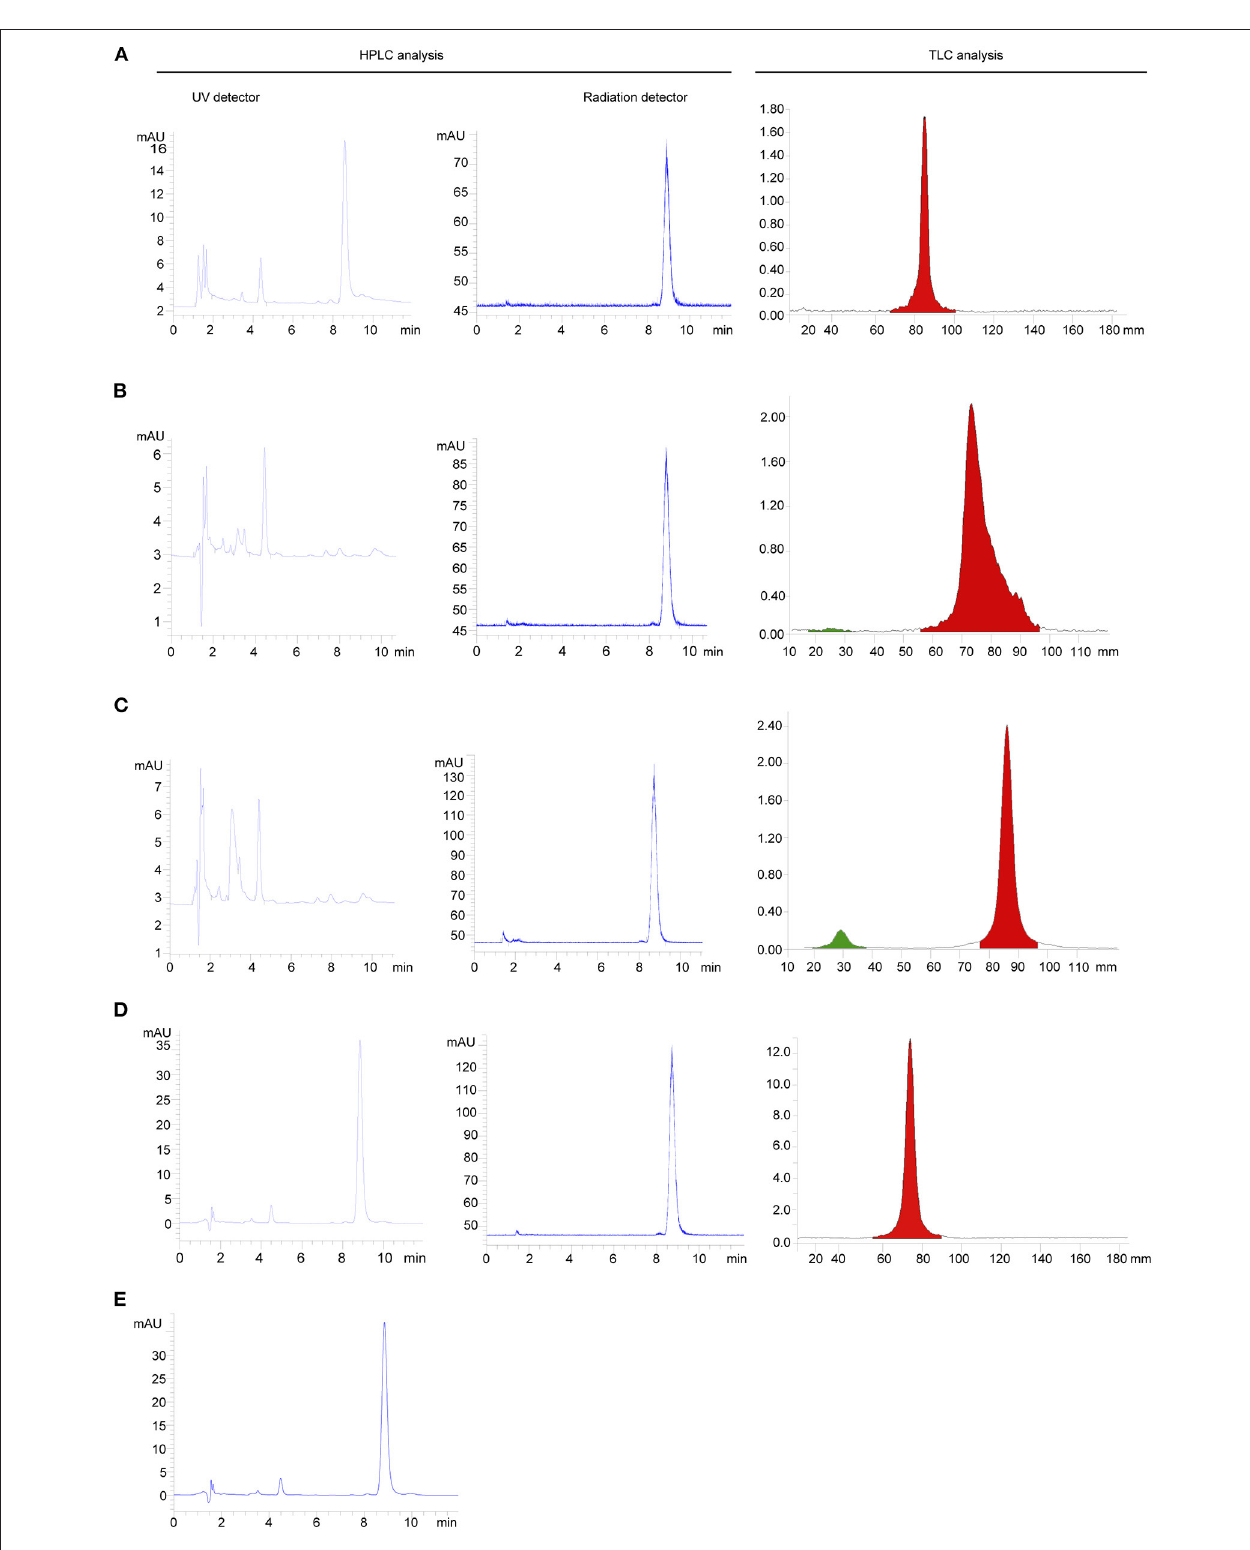
FIGURE 4 | HPLC and TLC analysis of radiochemical purity of 18 F-FP-( + )-DTBZ purified by HPLC (A) , SPE with Sep-Pak PS-2 (B) , SPE with Sep-Pak C18 (C) SPE with combined use of Sep-Pak PS-2 and Sep-Pak C18 (D) , and radiochemical purity of FP-( + )-DTBZ (E) .